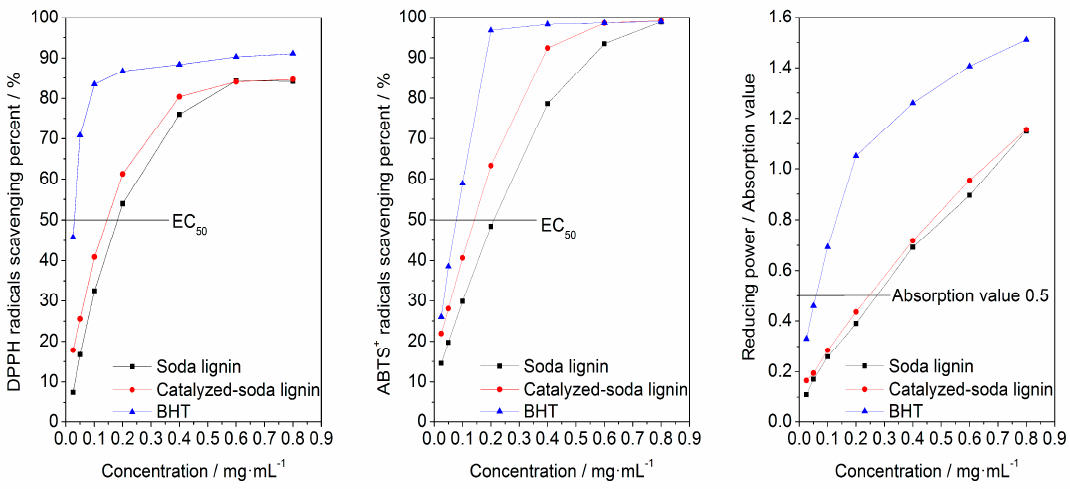
Figure 6. DPPH radicals scavenging and ABTS + radicals scavenging percent and the reducing power of lignin samples. BHT: butylated hydroxytoluene.